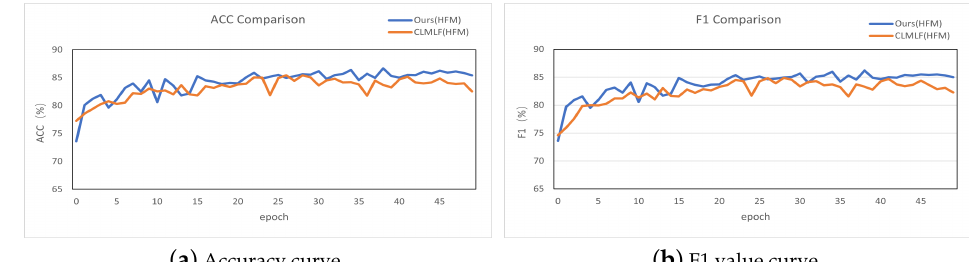
Figure 4. Accuracy and F1 value plot.